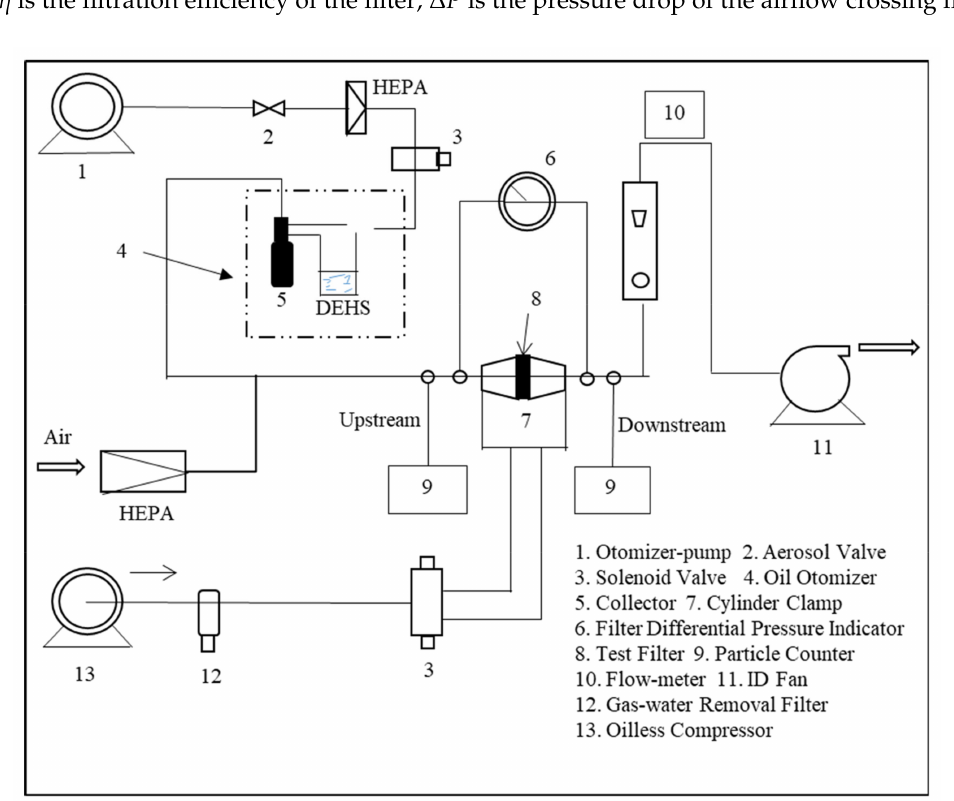
Figure 1. Experimental set-up for testing filtration e ffi